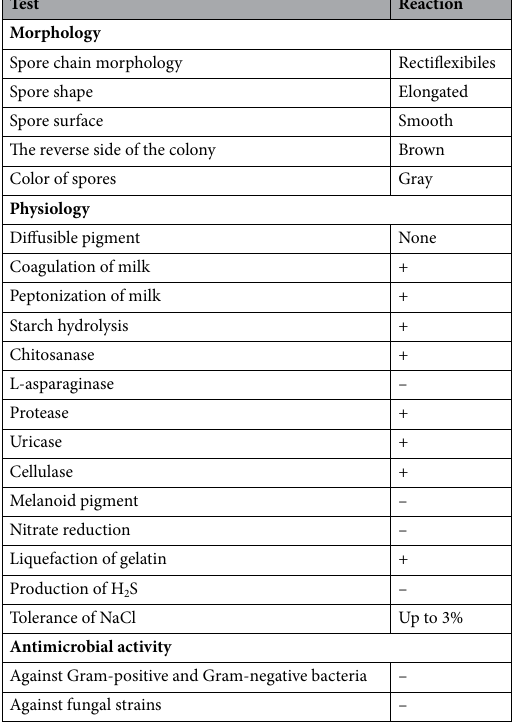
Table 1. Morphological, physiological, and antimicrobial properties of Streptomyces NEAE-83. Positive reaction; +, Negative reaction; –, Bacterial strains were Staphylococcus aureus , Pseudomonas aeruginosa , Klebsiella , Escherichia coli , Fungal strains were Fusarium solani , Alternaria solani , Fusarium oxysporum , Bipolaris oryzae , Rhizoctonia